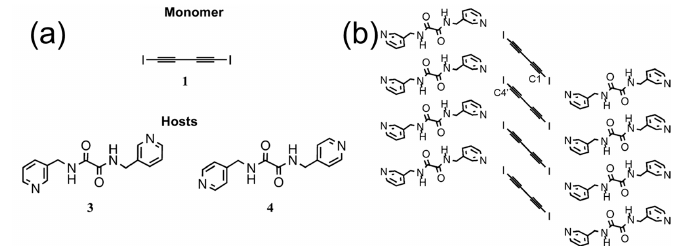
Figure 8. ( a ) The structure of diiodobutadiyne and 3-pyridyl host, 4-pyridyl host [99]. ( b ) The structure of cocrystal 4 [99].